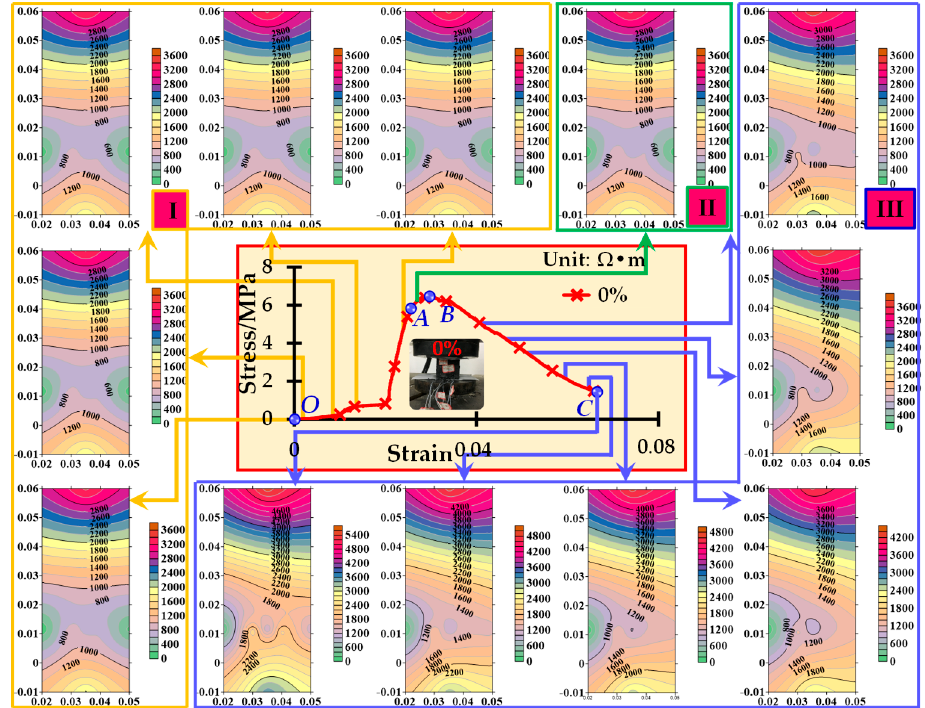
Figure 13. Variation charts of specimen with no graphite addition at different stages.